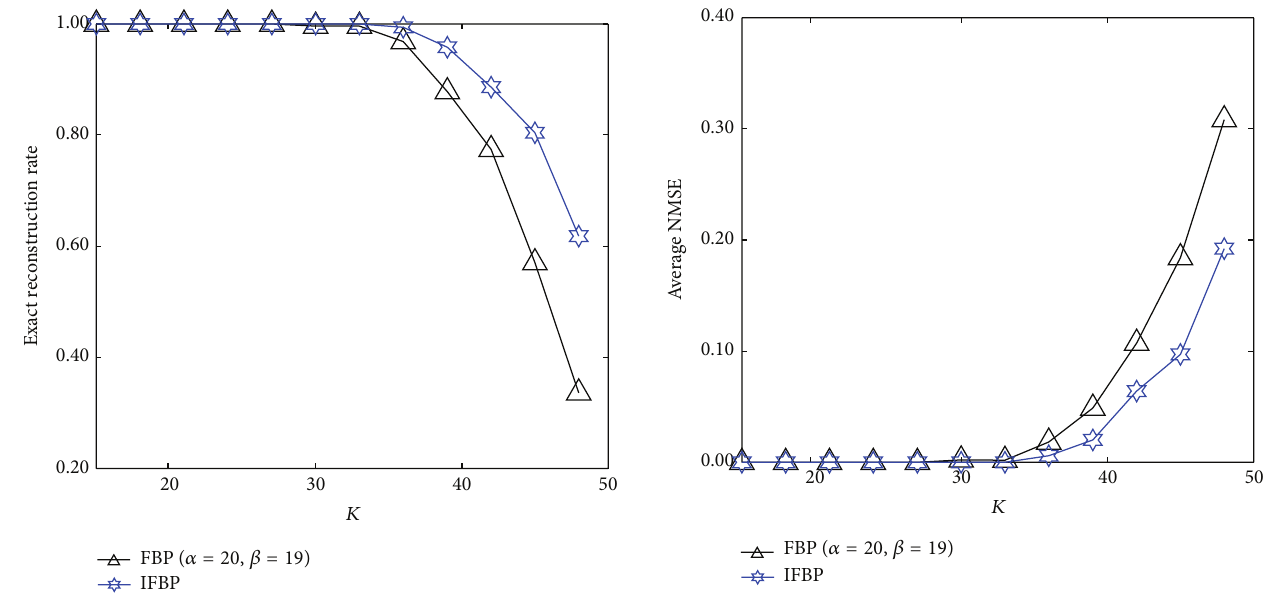
Figure 2: Average NMSE for the Gaussian sparse vectors ( 𝛼 = 20 , 𝛽 = 19 ).